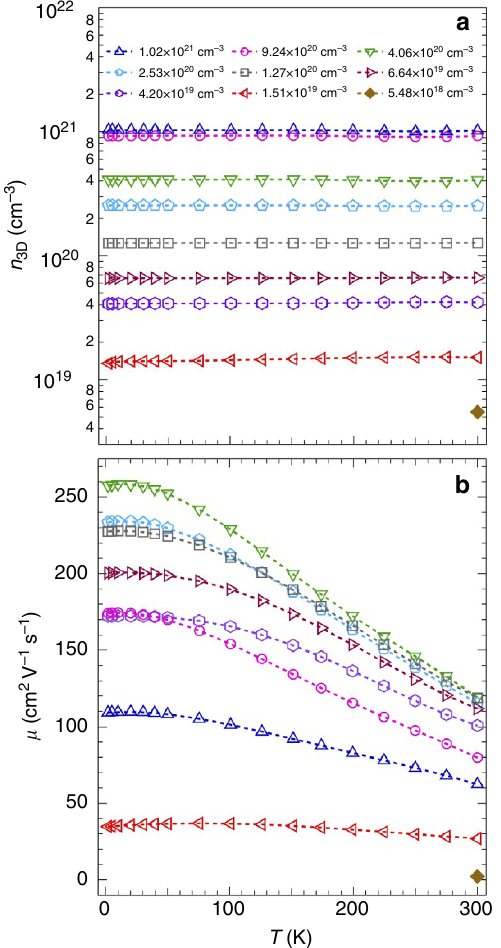
Figure 3 | Temperature dependence of carrier concentration and mobility. ( a ) n 3D , and ( b ) m as a function of temperature ( T ) for doped BSO films with different n 3D